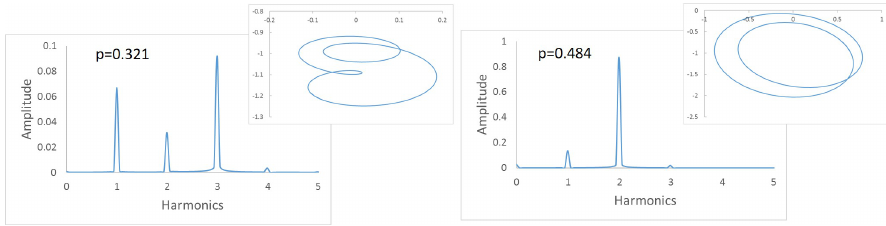
Figure 7. Frequency spectrum of a cracked shaft: α = 0.45, p = 0.321, and p =